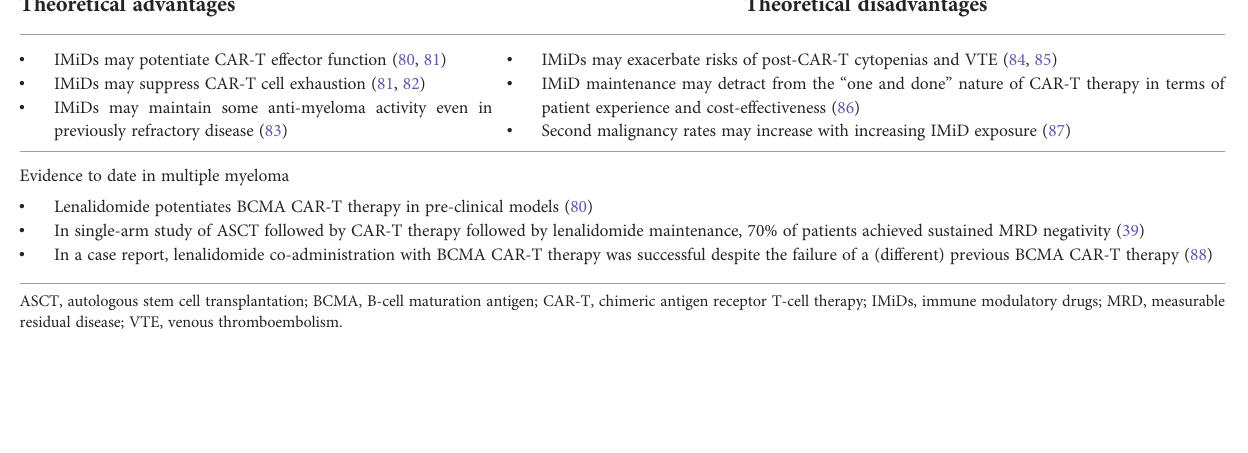
TABLE 2 Rationales for/against IMiD maintenance following BCMA CAR-T